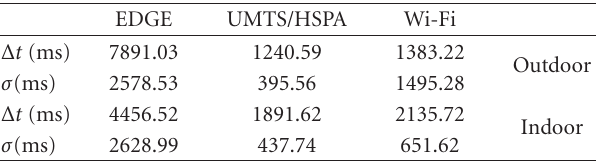
Table 1: Time needed to download the map and route for naviga- tion.